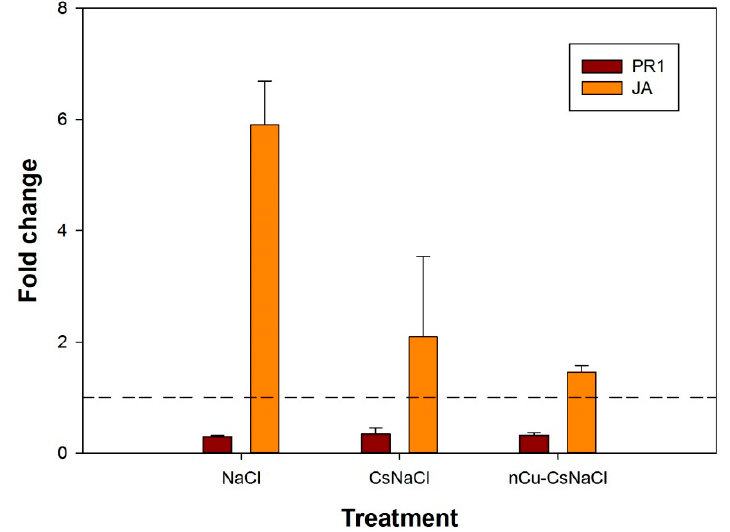
Figure 4. Expression of PR1 and JA genes in tomato leaves after 48 h under salt stress (23 days after transplant). NaCl: witness + 100 mM NaCl. CsNaCl: Cs-PVA + 100 mM NaCl. nCu-CsNaCl: Cs-PVA + 10 mg Cu NPs + 100 mM NaCl. The data represent the mean ± standard error and the reference line represents the constant value of the absolute control.